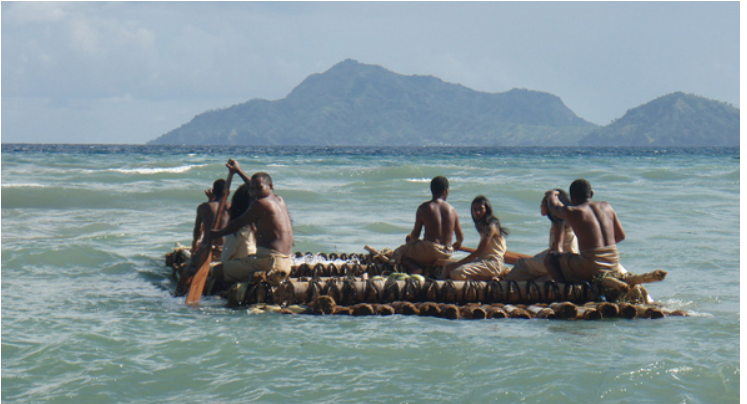
Figure 10. Colonizing seafaring began with bamboo rafts almost one million years ago in the islands of